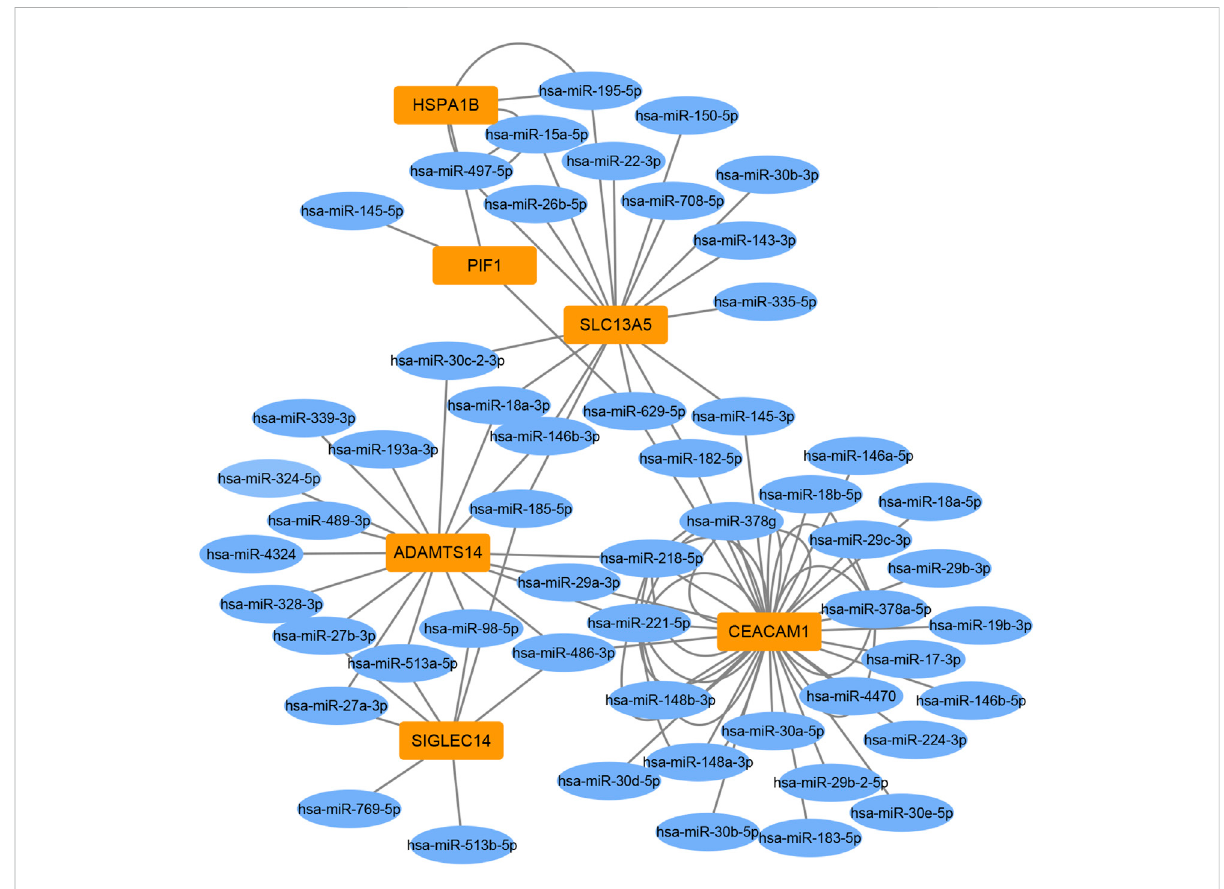
FIGURE 6 Construction of miRNA-target gene interaction